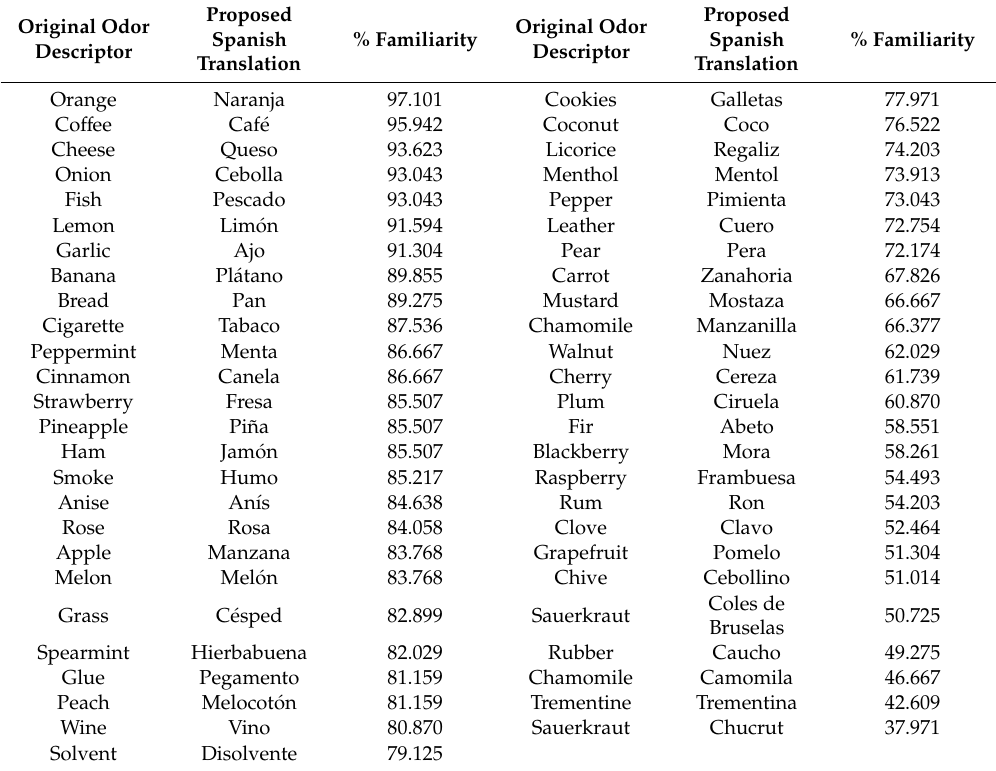
Table 1. Familiarity percentage of OI answer